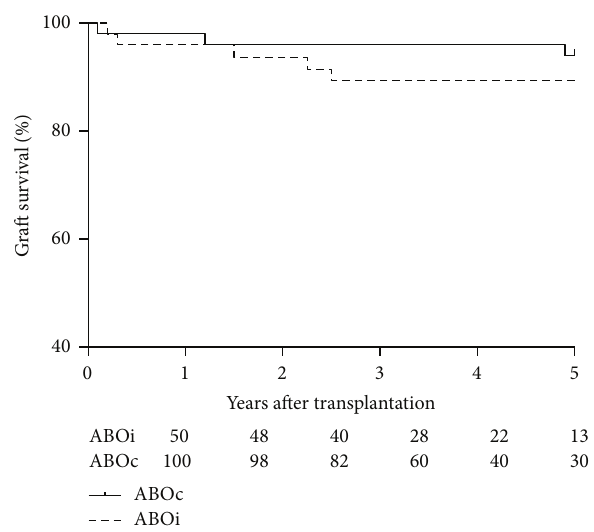
Figure 1: Renal allograft survival censored for death in the blood group ABO incompatible ( 𝑛 = 50 ) and matched ABO compatible ( 𝑛 = 100 ) transplantations. Numbers of patients in study at every year after transplantation are shown below the 𝑥